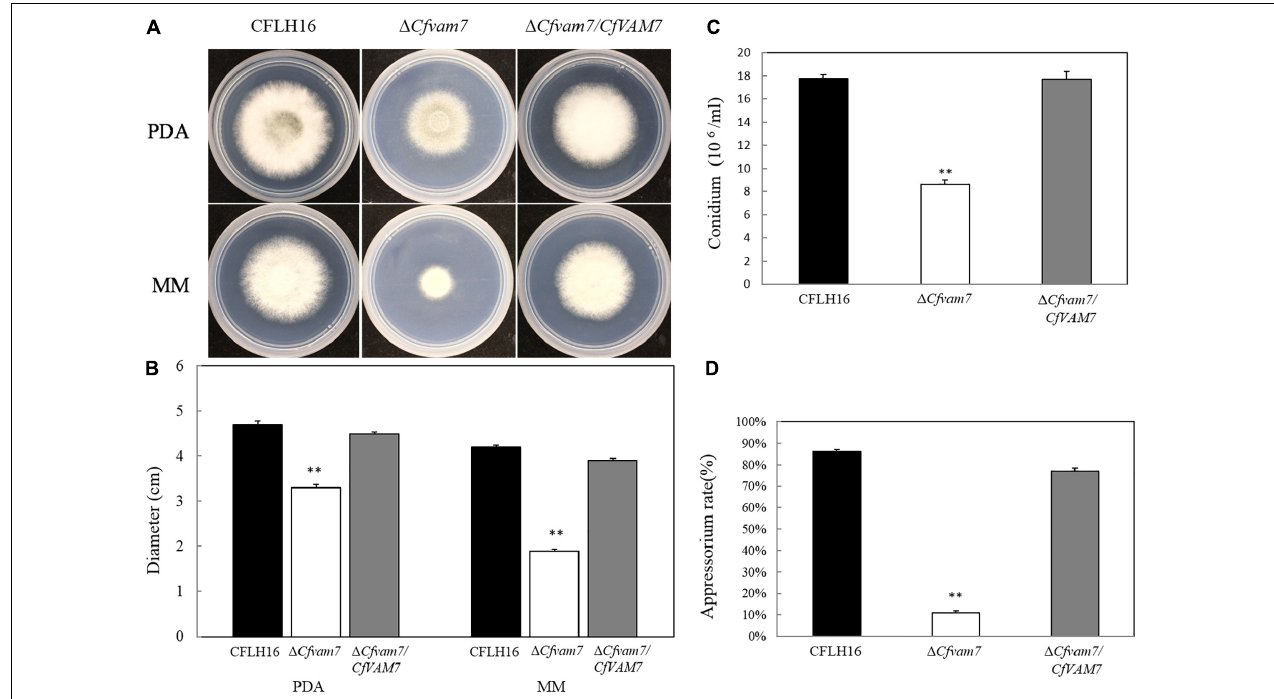
FIGURE 2 | CfVam7 is involved in vegetative growth, sporulation, and appressorium formation. (A) Growth rate of strains on potato dextrose agar (PDA) and MM media. (B) Statistical analysis of the colony diameter variations. (C) Conidium formation rate. (D) Appressorium rate. Error bars are standard deviation, and asterisks represent significance at p < 0.01 ( ∗∗